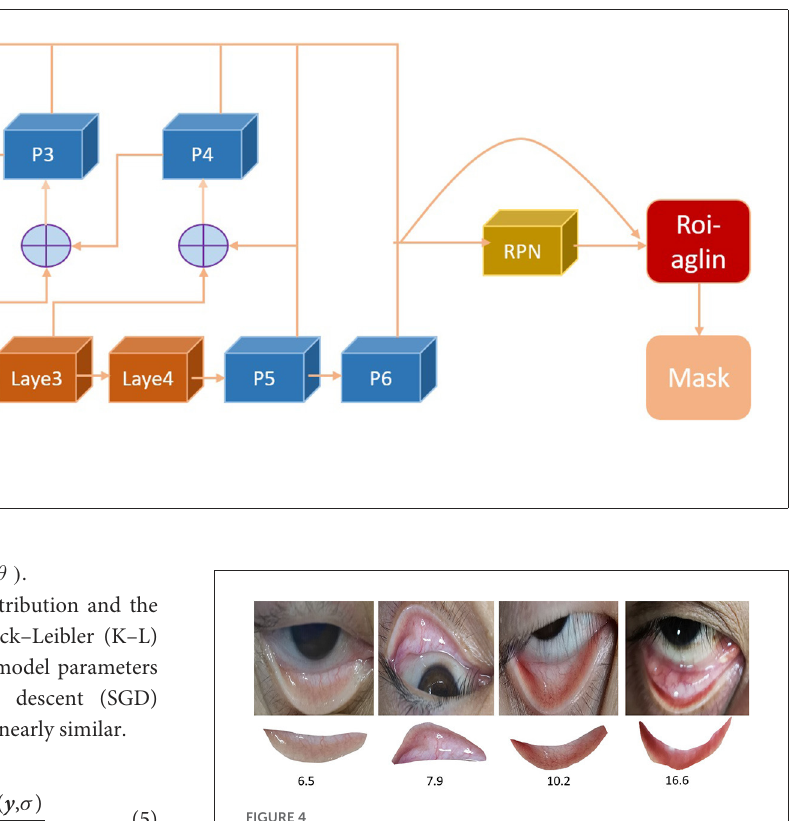
FIGURE4 Raw input eye and eyelid